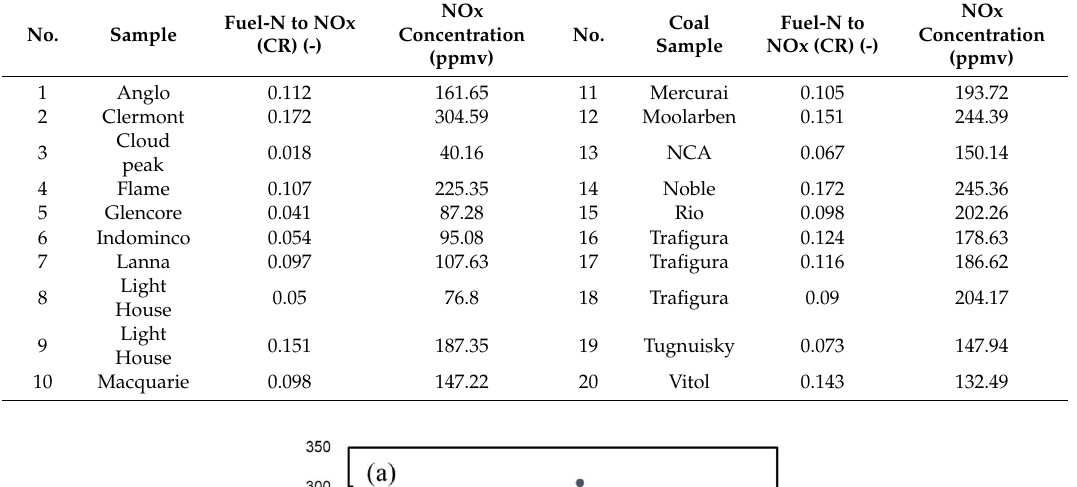
Table 2. Fuel-N to NOx values and DTF NOx concentration at the exit.